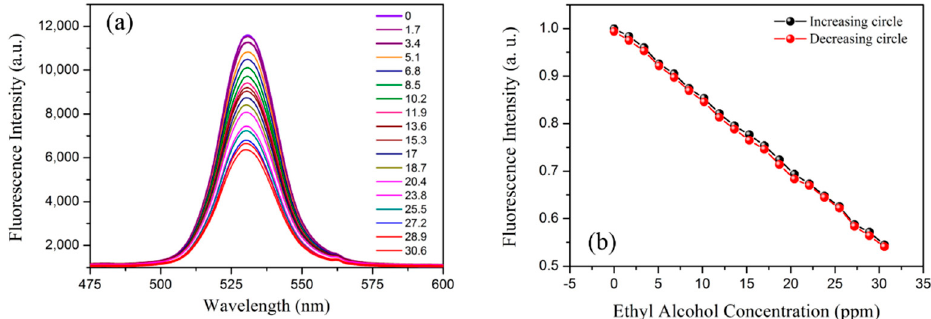
Figure 5. ( a ) The evolution of the fluorescence spectra of QDs using different ethanol vapor concentrations. ( b ) The normalized fluorescence intensity as a function of ethanol concentration.